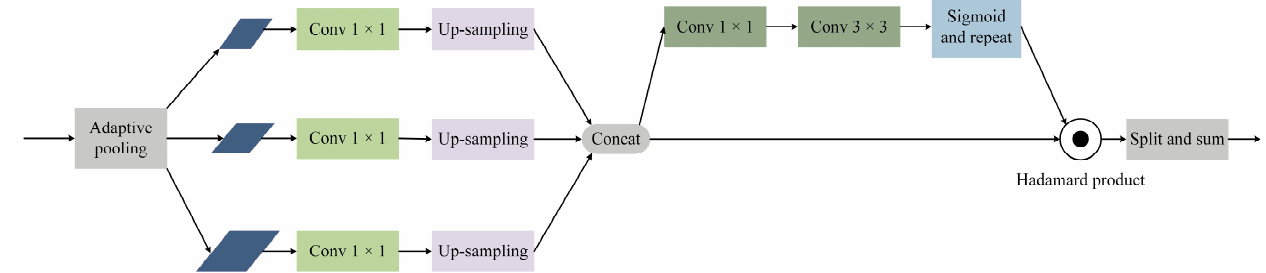
Figure 3. Residual feature augmentation module.